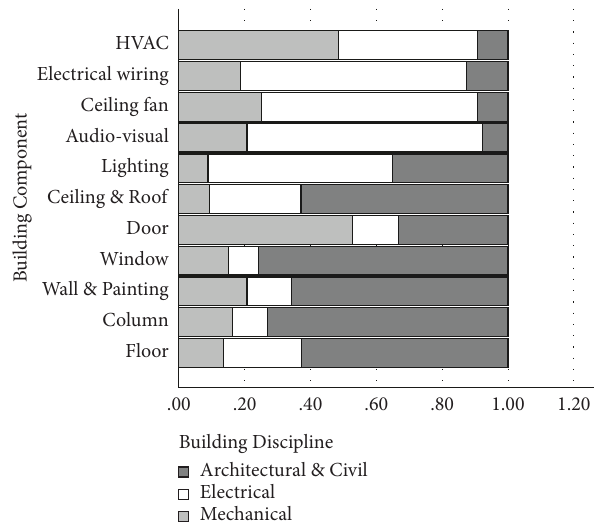
Figure 5: Comparison of building components with respect to each building